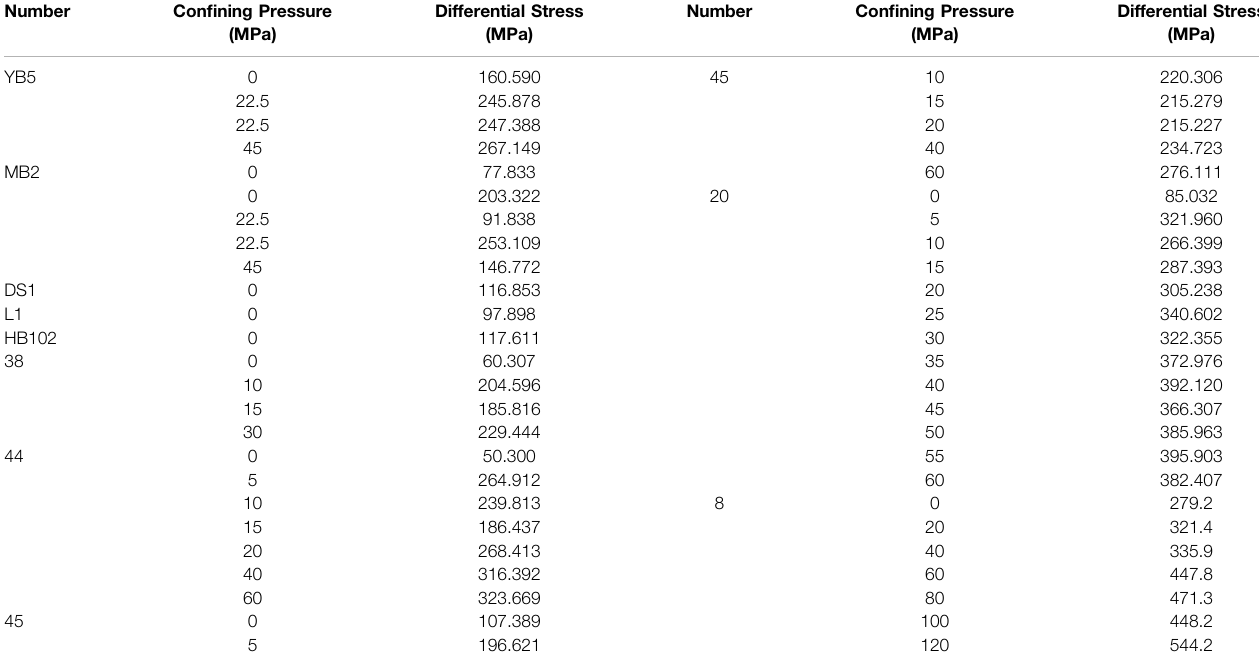
TABLE 2 | Strengths of the limestones in the Sichuan basin under various con fi ning